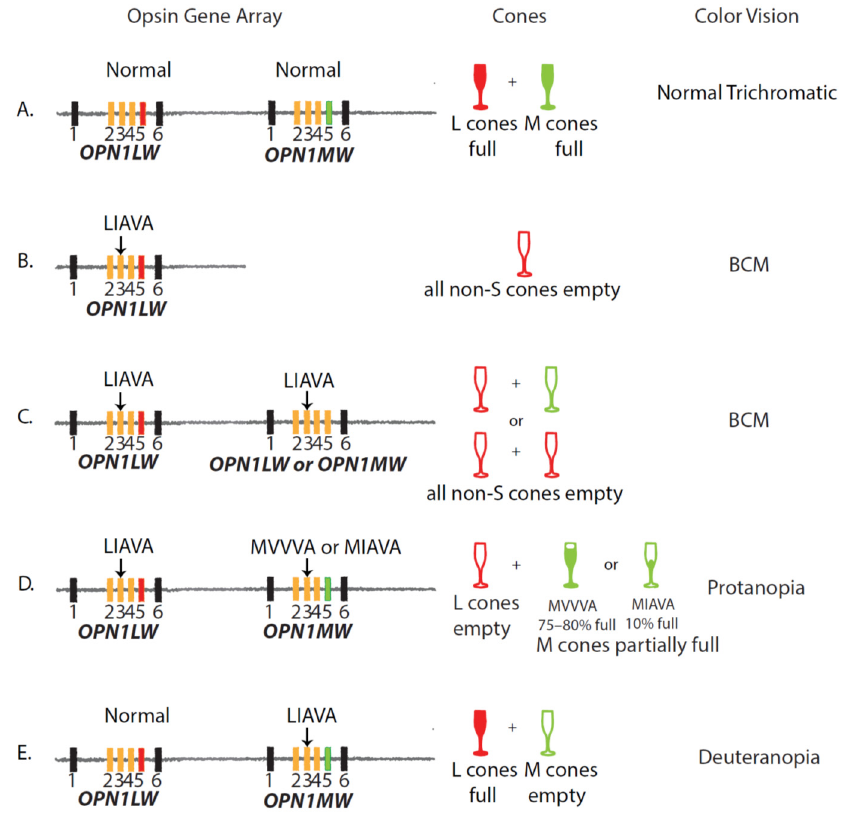
Figure 3. ( A ) Arrays with an OPN1LW gene followed by an OPN1MW gene, each with haplotypes that splice normally, give rise to L and M cones that have a normal amount of photopigment, which in turn confers normal, trichromatic red-green color vision. Exons are represented by the numbered rectangles, and the color-coding is the same as that described in Figure 2. ( B ) An array with a single OPN1LW LIAVA gene does not produce any functional photopigment, so all cones except-S cones are devoid of pigment, and a male with this array is an obligate Blue Cone Monochromacy (BCM). ( C ) An array in which the first two genes have the LIAVA haplotype will cause BCM regardless of whether the second gene encodes an OPN1LW or OPN1MW gene (indicated by a yellow rectangle for exon 5) because all cones except S cones will be devoid of photopigment. ( D ) An array in which the first gene is OPN1LW LIAVA and the second gene is either OPN1MW MVVVA or OPN1MW MIAVA will cause protanopia in males because the L cones will be devoid of photopig- ment, and the M cones will have photopigment. Thus, color vision will be mediated by M and S cones. ( E ) An array in which the OPN1LW gene has a normal (non-exon 3-skipping) haplotype and the second gene is an OPN1MW LIAVA will cause deuteranopia in males because only L cones and S cones will contain functional photopigment. Arrays in this figure correspond to those found in patients described in Tables S1–S3 [22,27,31,33,39]. The fovea is the center of the field of vision and the location of the highest visual acuity. Cone photoreceptors are concentrated in the fovea. In conventional vision charts, a person with normal visual acuity is able to resolve 1 min of arc of visual angle. The size of each letter is such that its strokes will subtend 1 min of arc at a specified distance. In standard notation, visual acuity is as a fraction where the numerator indicates the viewing distance, and the denominator indicates the size of the letter. At 20 feet away, an observer who can just recognize the line on the chart with letters having strokes of 1 min of arc has a visual acuity of 20/20. An observer who requires letters twice that size has an acuity of 20/40, and so forth. Under ideal conditions, an observer with excellent vision can just re- solve the fine detail for which the angular subtense approaches that of a single cone [72]. L- and M-cones mediate high-acuity achromatic spatial vision. Blue cone monochromacy